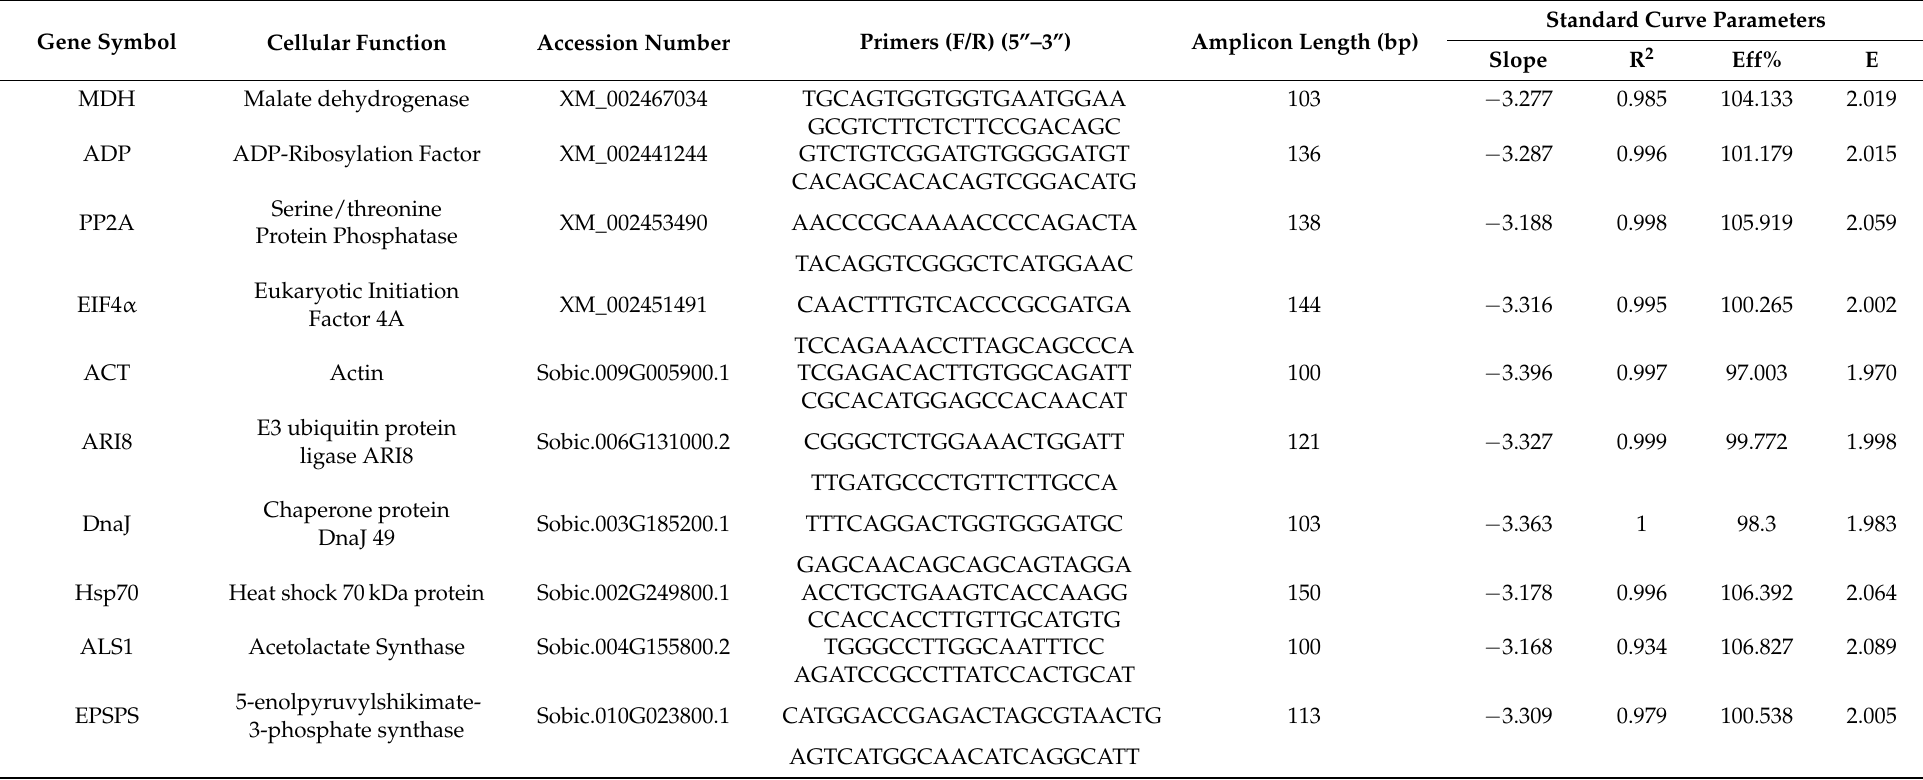
Table 1. Information on the primer pairs selected and amplification details. Slope: slope of standard curve; R 2 : correlation coefficient value for standard curve; Eff%: PCR efficiency [%]; E: primer efficiency calculated according to E = 10 − 1/slope